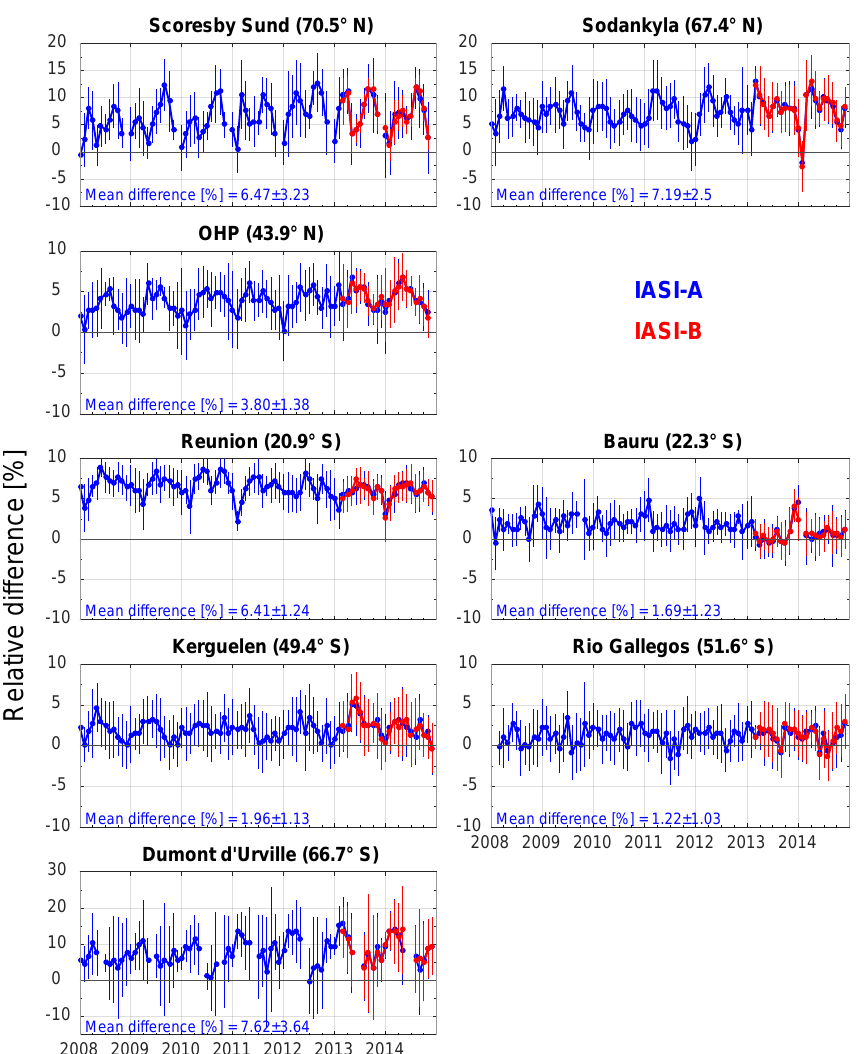
Figure 12. Monthly mean relative differences (in percent) between IASI-A (blue) and IASI-B (red) TOCs against co-located SAOZ TOCs for eight stations from north to south. For the period March 2013 onwards, only the common co-locations between the two satellites are shown. The error bars display the associated monthly mean standard deviation. The 7-year mean relative difference and standard deviation (in percent) are indicated on each panel. The relative difference (in percent) is calculated as (100 × (IASI − SAOZ) /